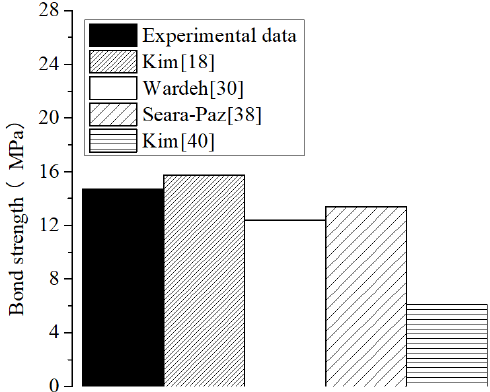
Figure 3: Comparison between predicted values and experimental values of bond